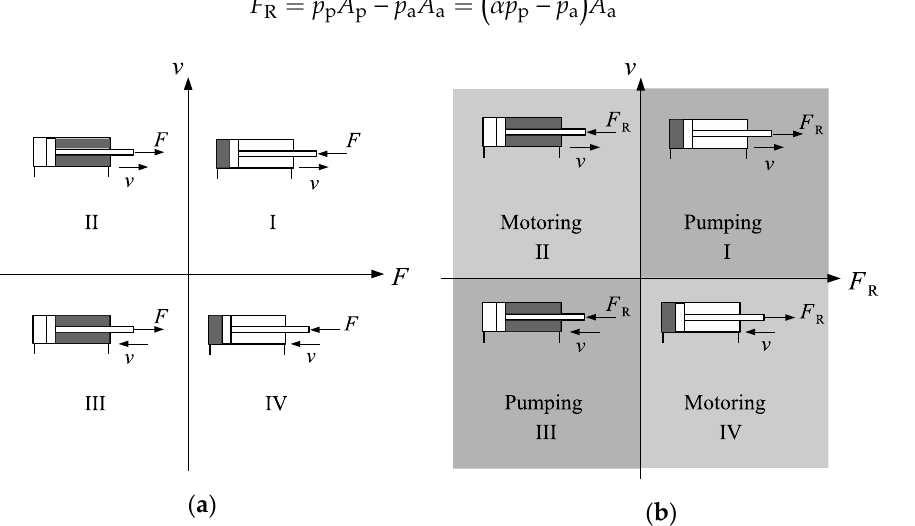
Figure 3. Operational quadrant divisions: ( a ) External force versus velocity; ( b ) actuator force versus velocity.